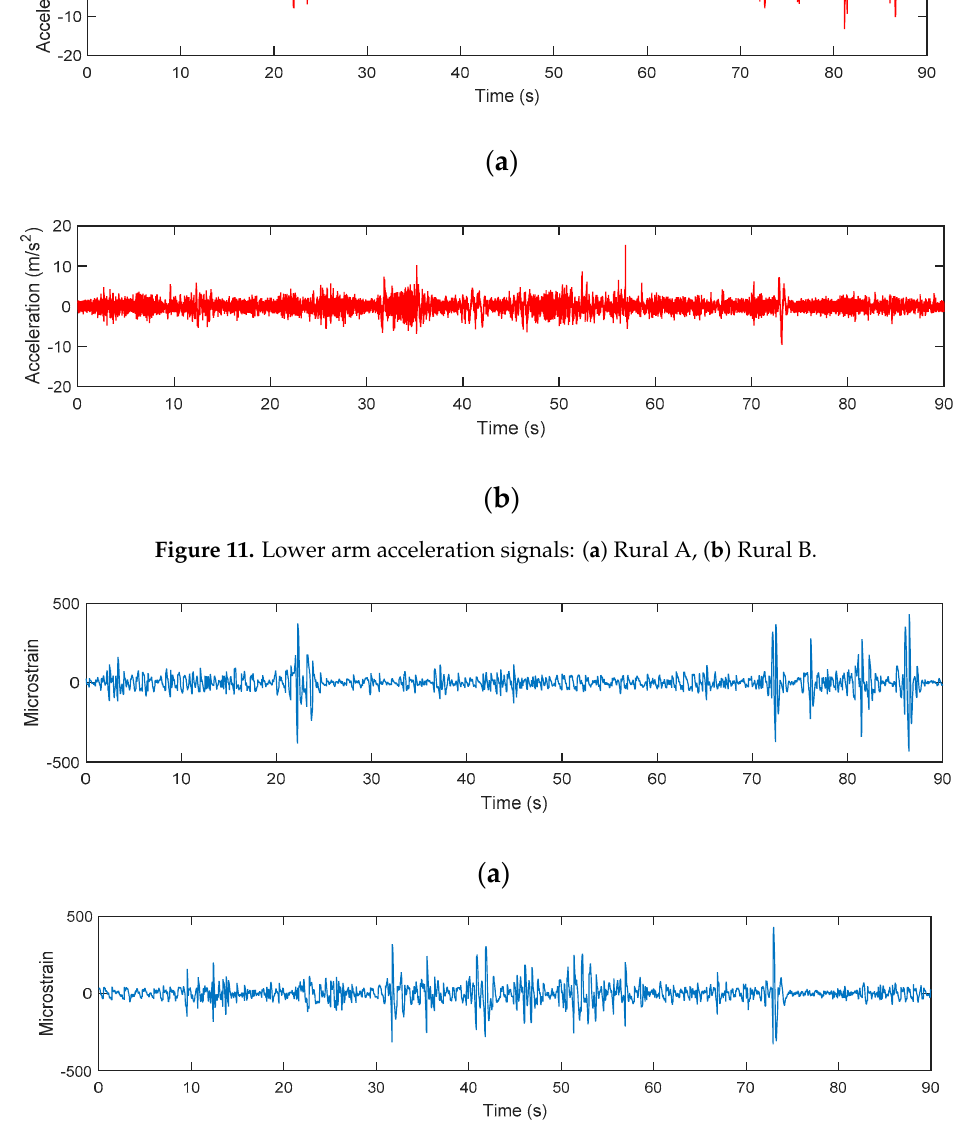
Figure 12. Elastic-energy strain signals: ( a ) Rural A, ( b ) Rural B.